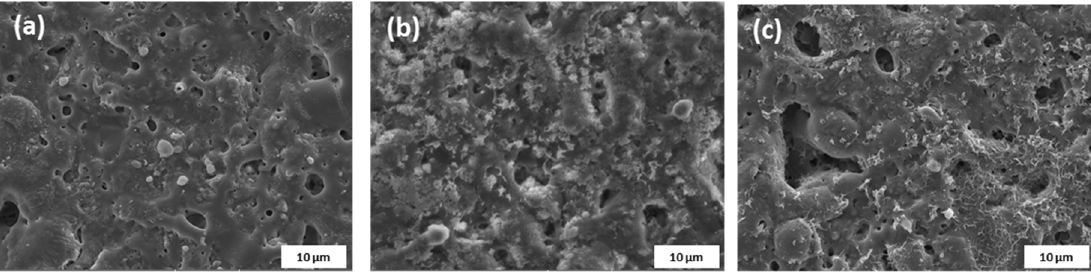
Figure 2. ( a ) SEM micrograph of PEO sample; ( b ) PEO sample with LDH ‐ NO 3 ; and ( c ) PEO sample with LDH ‐ VO x .